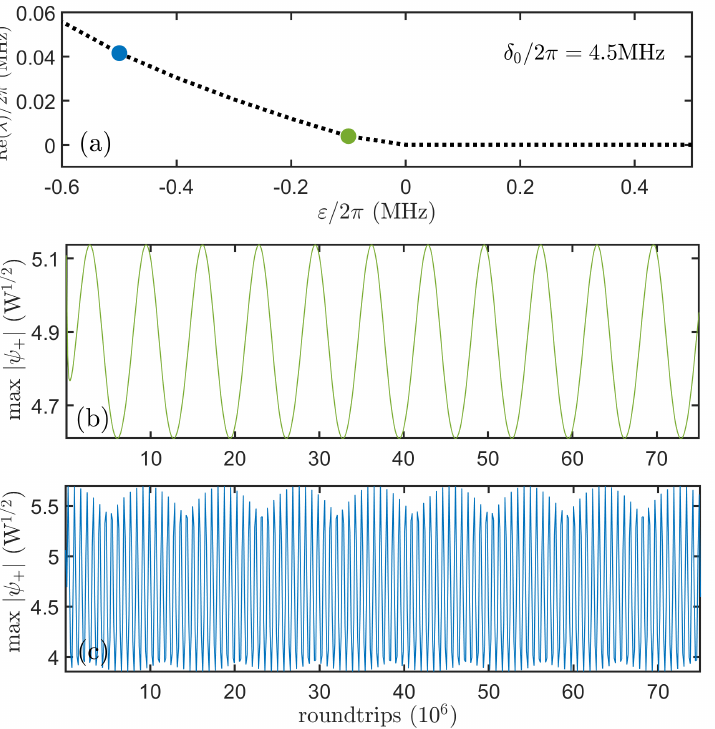
Figure 8. ( a ) The maximal growth rate of the soliton instability found on the right from the blockade interval in Figure 2c. ( b , c ) The soliton breather states found for the green and blue dots in ( a ),